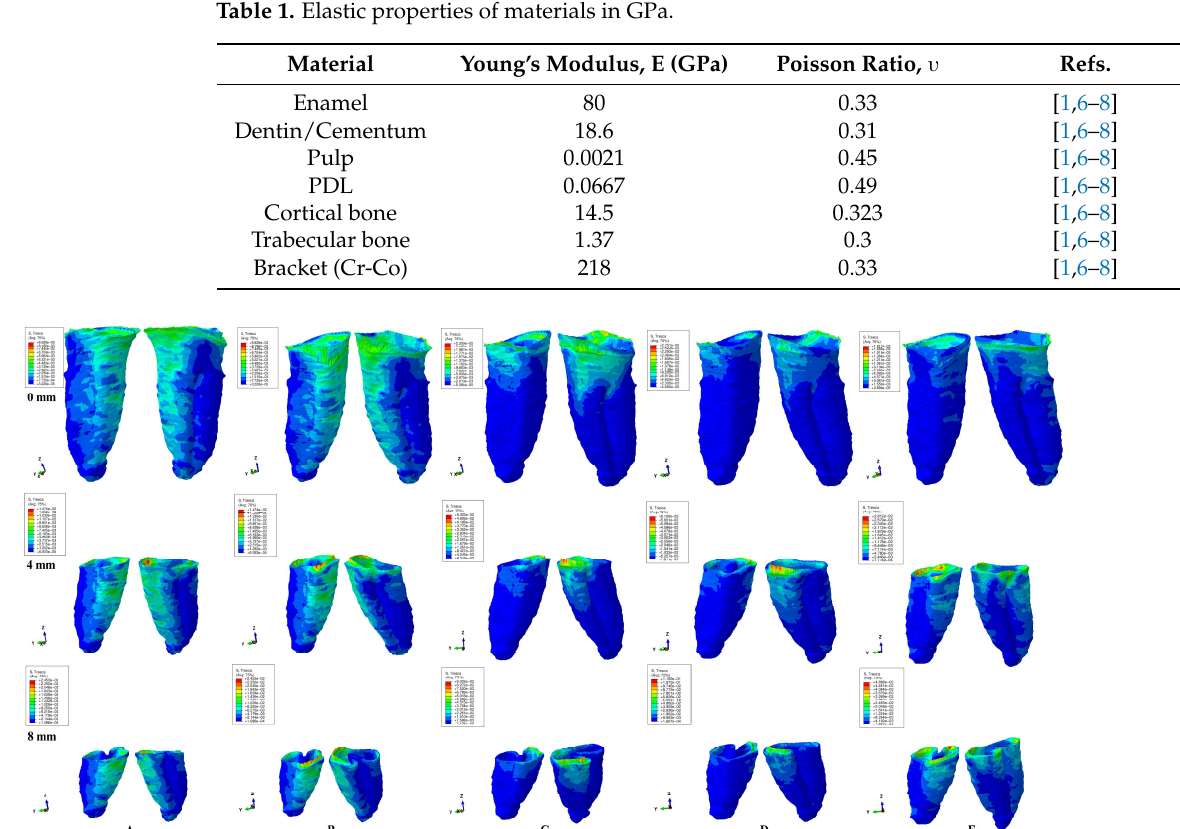
Figure 2. Tresca shear stress display in PDL for 0.6 N (the quantitative values are in MPa) (intact, 4 mm and 8 mm reduced periodontium—vestibular-distal and mesial-lingual view): ( A )—intrusion, ( B )—extrusion, ( C )—translation, ( D )—rotation, and ( E )—tipping; the highest stressed areas are color coded in red and orange. Table 2. The Tresca shear stress average values (KPa) produced by 0.6 N of orthodontic forces. Resorption (mm)